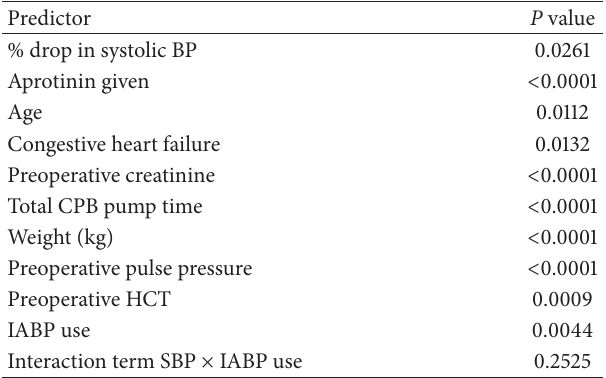
Figure 1: Association of % change in systolic blood pressure and percent decline in creatinine in the combined sample ( 𝑛 = 7504 ) Predicted values are derived from a multivariable linear regression model which incorporates restricted cubic splines. This allows the slope of the line to vary over the range of values on the 𝑥 -axis to represent a nonlinear association. The shaded area represents 95% confidence intervals for the predicted values, which are represented with the dotted line. Table 4: Multivariable linear regression model showing association between % change in SBP and percent delta creatinine with interac- tion variable intraoperative balloon